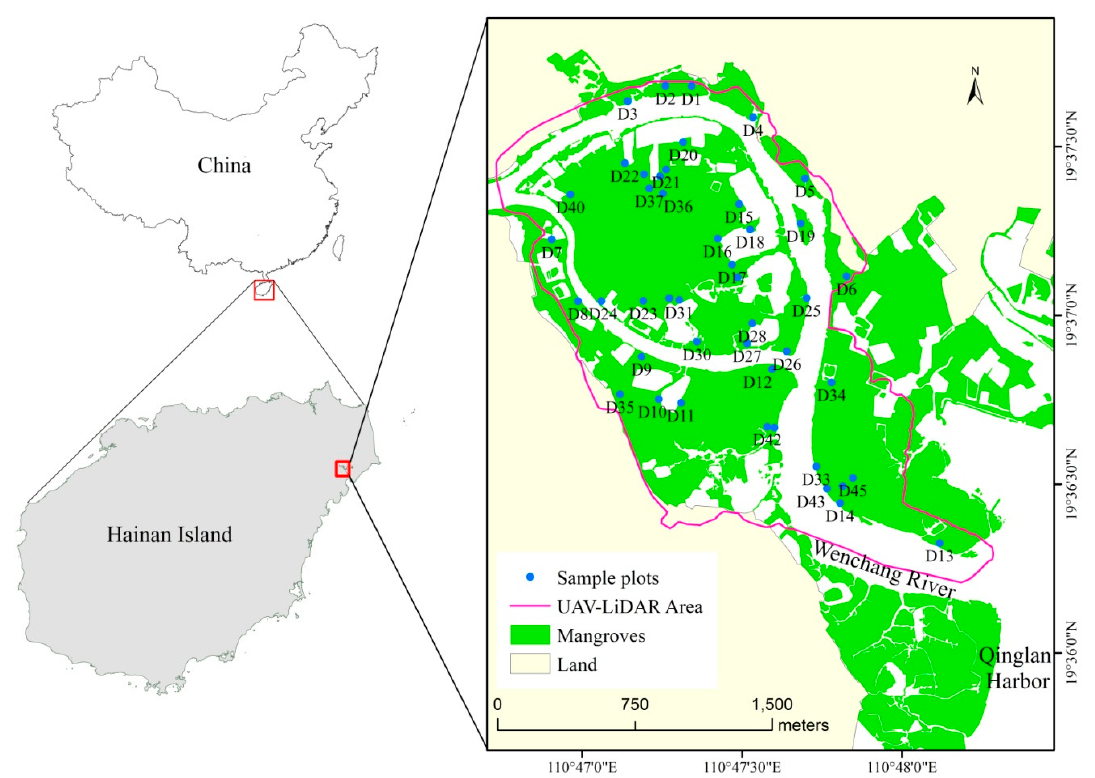
Figure 1. Location of the study area and the sampling plots.